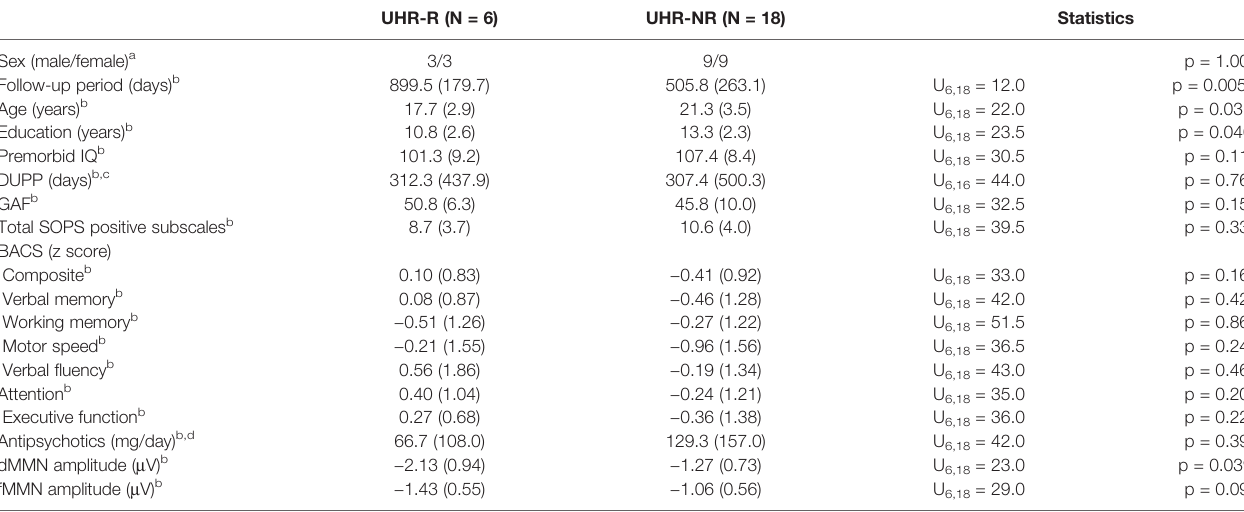
TABLE 3 | Baseline demographic and clinical characteristics of the UHR-R and UHR-NR